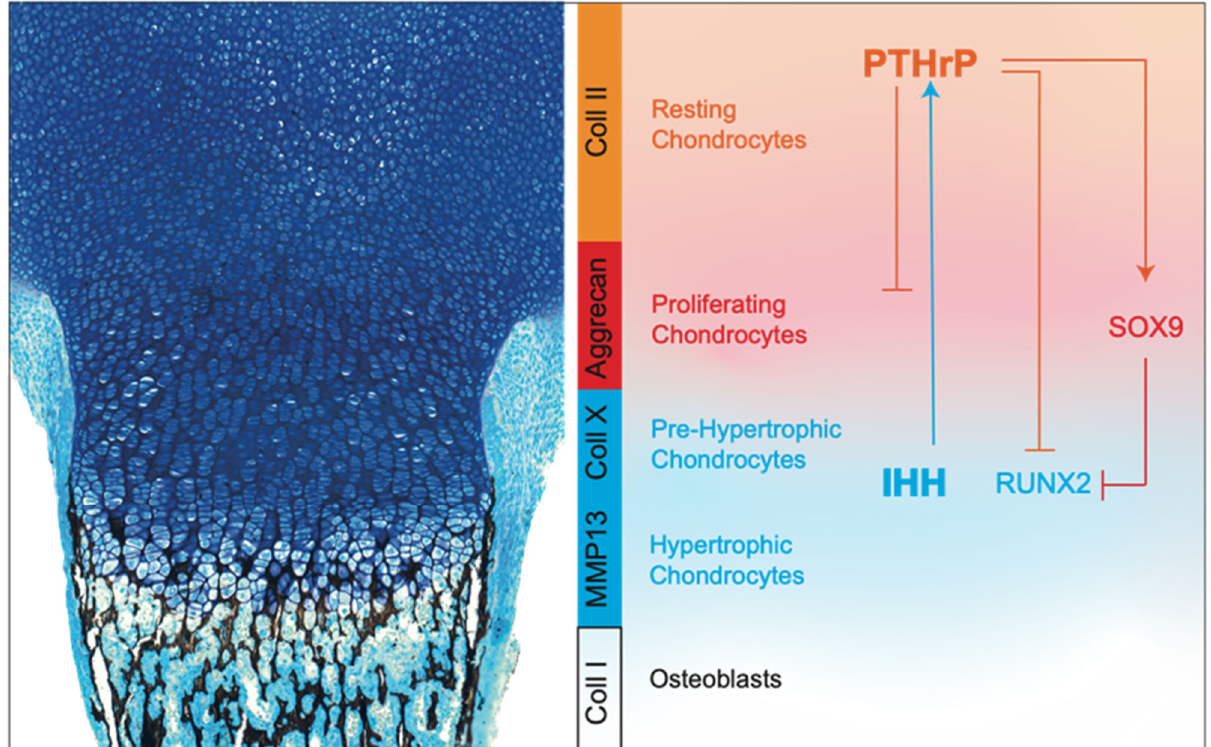
Figure 4. Main transcription factors and signaling pathways in endochondral bone formation. The left panel shows an undecalcified von Kossa/methylene blue-stained section of the femur of 1-day-old mouse showing mineralized matrix (black color) in the hypertrophic zone and in the underlying trabecular bone. The right panel illustrates the main matrix proteins and molecules secreted by chondrocytes and their transcription factors’ expression during the different differentiation stages. Resting and proliferating chondrocytes express SOX9 and produce collagen type II and aggrecan, respectively; pre-hypertrophic and hypertrophic chondrocytes express IHH, which induces the expression of PTHrP close to the articular region. PTHrP, in turn, blocks the expression of IHH in lower chondrocytes and regulates chondrocyte proliferation and hypertrophy. In addition, PTHrP maintains chondrocytes in their proliferative phase, promoting the activity of SOX9 and the